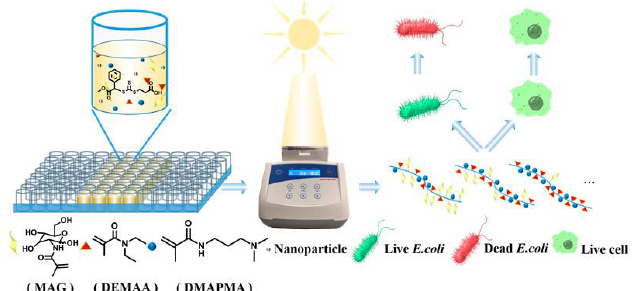
Figure 7. High − throughput open polymerization to prepare glycopolymers containing hydrophobic fragments and cations [47].